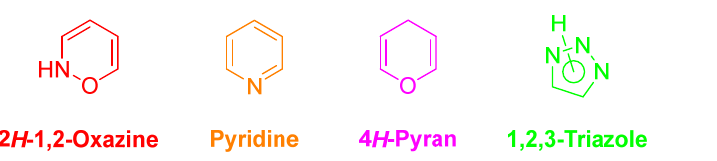
Figure 1. Structures of BA and three BA-based synthetic derivatives: bevirimat, BMS-955176 and GSK’254, known as potent anti-HIV agents.